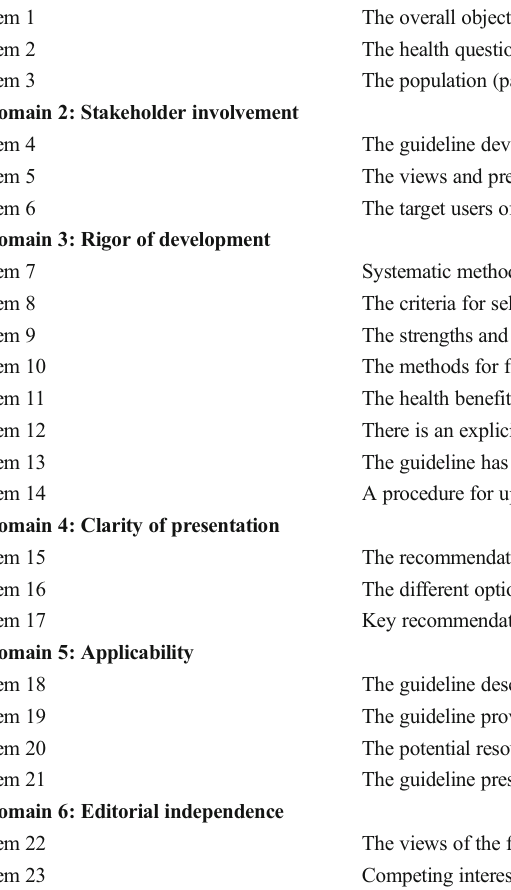
Table 1 Summary of AGREE II structure and detailed list of items within each domain (from reference 15) Domain 1. Scope and